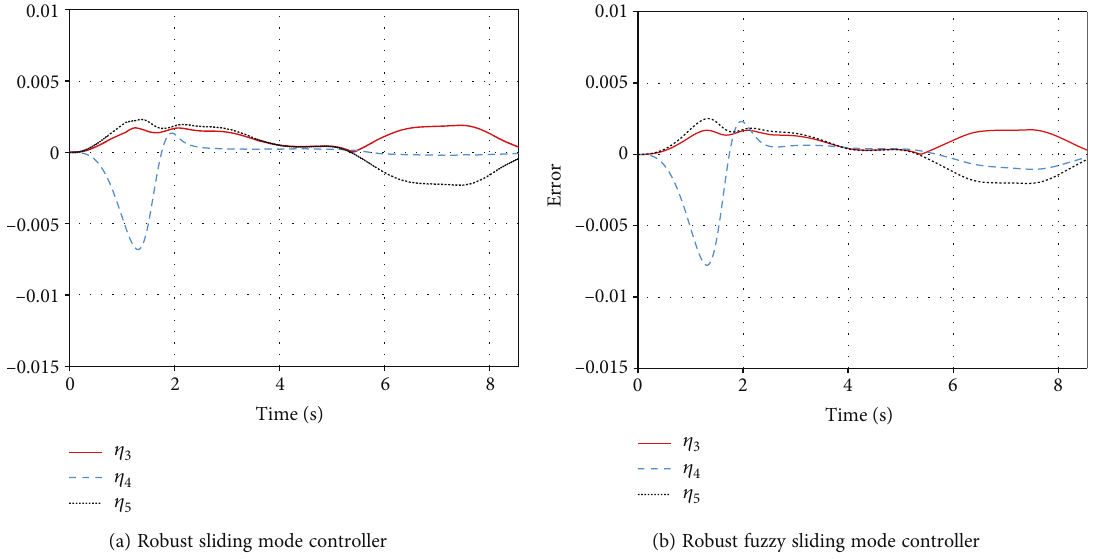
Figure 10: Comparison of tracking error of two control algorithms.